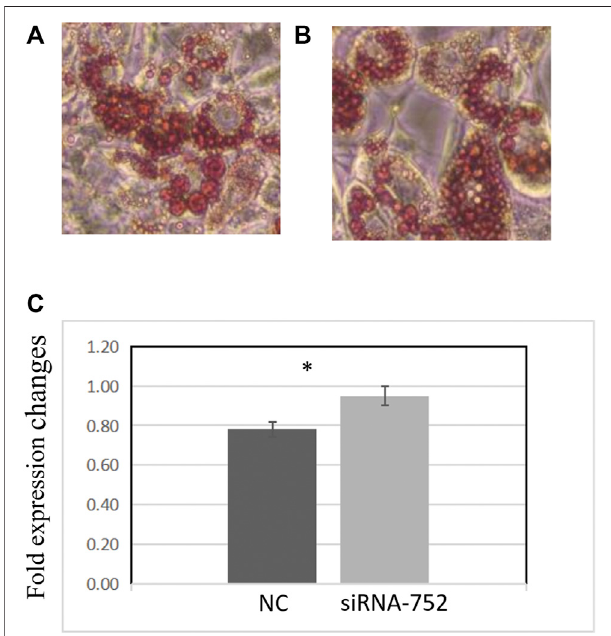
FIGURE 8 | Effectsof ANGPTL4 knockdown on the differentiation of pig preadipocytes (day 8). (A) Adipocyte differentiation in the negative control group ( × 20). (B) Adipocyte differentiation in the siRNA-752-treated group ( × 20). (C) Optical density (OD) values at 500 nm after Oil Red O staining. Data are presented as mean ± standard deviation. *Statistically signi fi cant differences ( p < 0.05, n (cid:1)